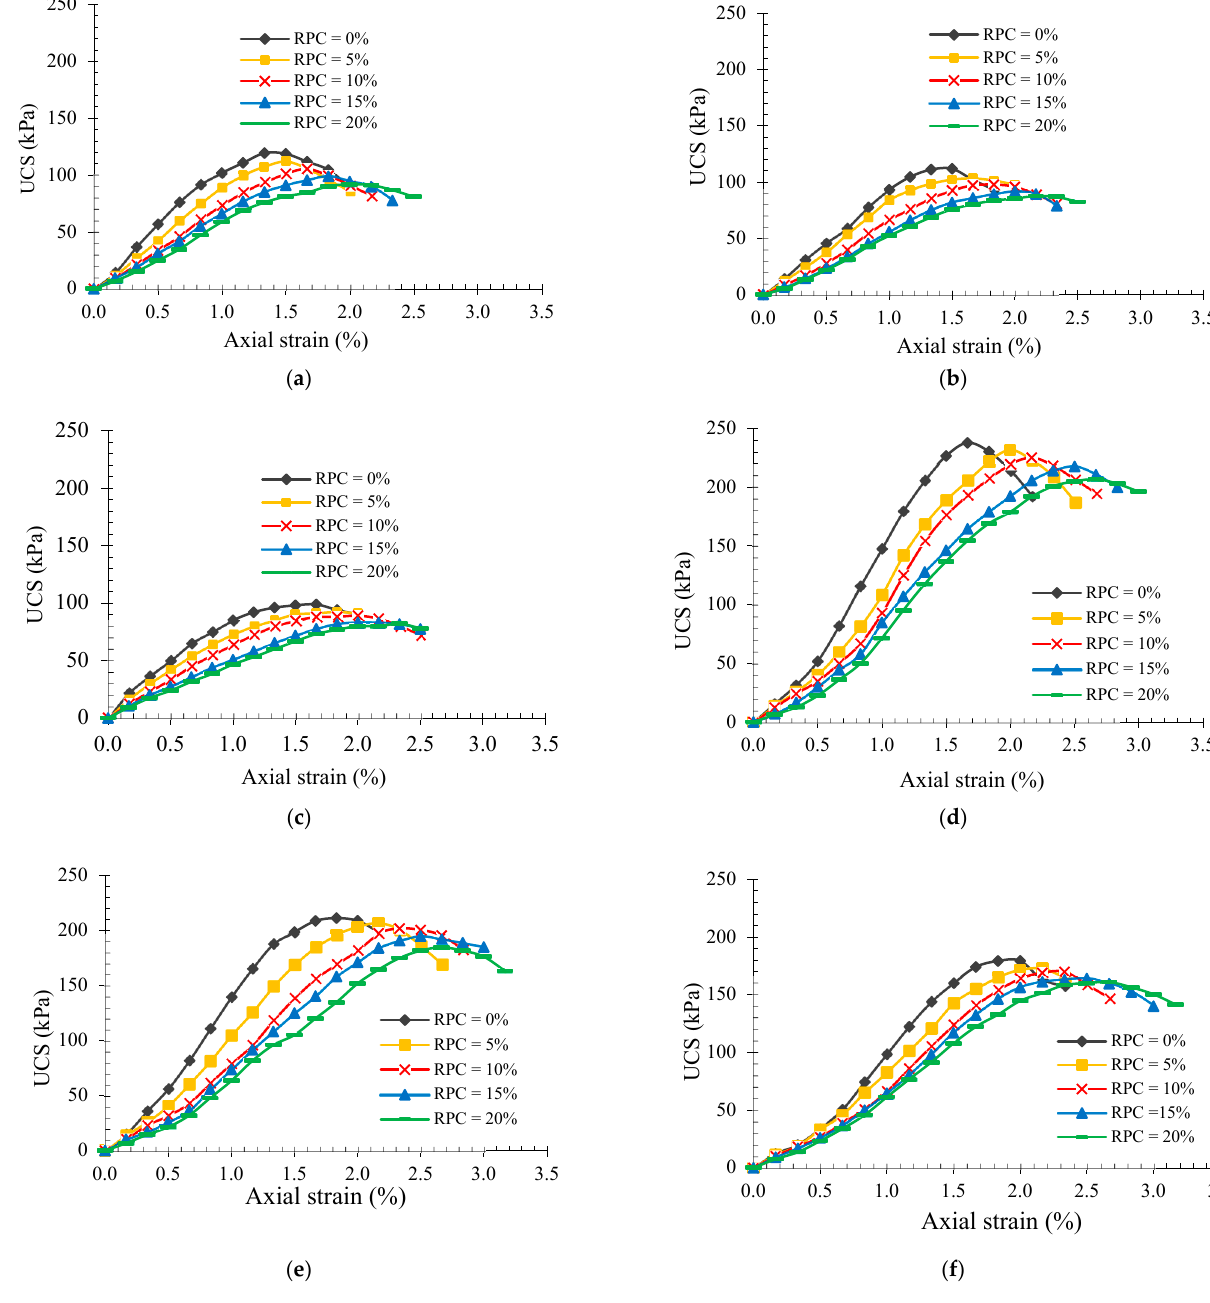
Figure 7. Stress–strain curves of 28-day cured samples ( a ) Sr = 0%, ( b ) Sr = 50% and ( c ) Sr = 100%, Group A; ( d ) Sr = 0%, ( e ) Sr = 50% and ( f ) Sr = 100%, Group B.